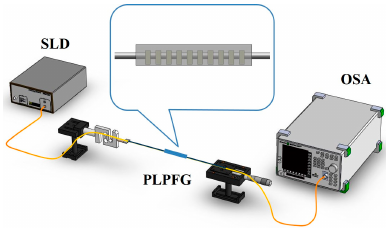
Figure 2. PLPFG tensile test setup diagram.